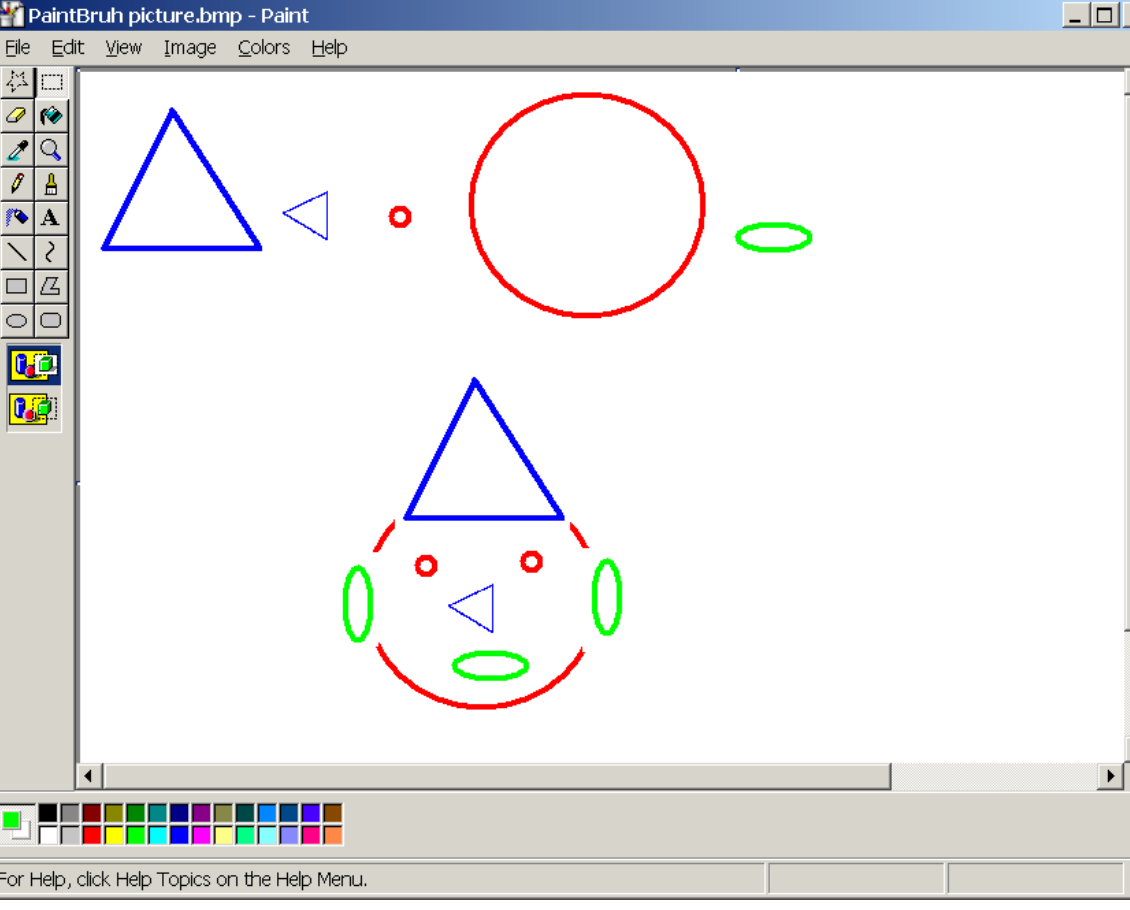
Picture 1. Eugene’s suggestion of a learning activity based on Microsoft Paint for Saul: Make a face out of the given geometrical figures (the presented face is a possible